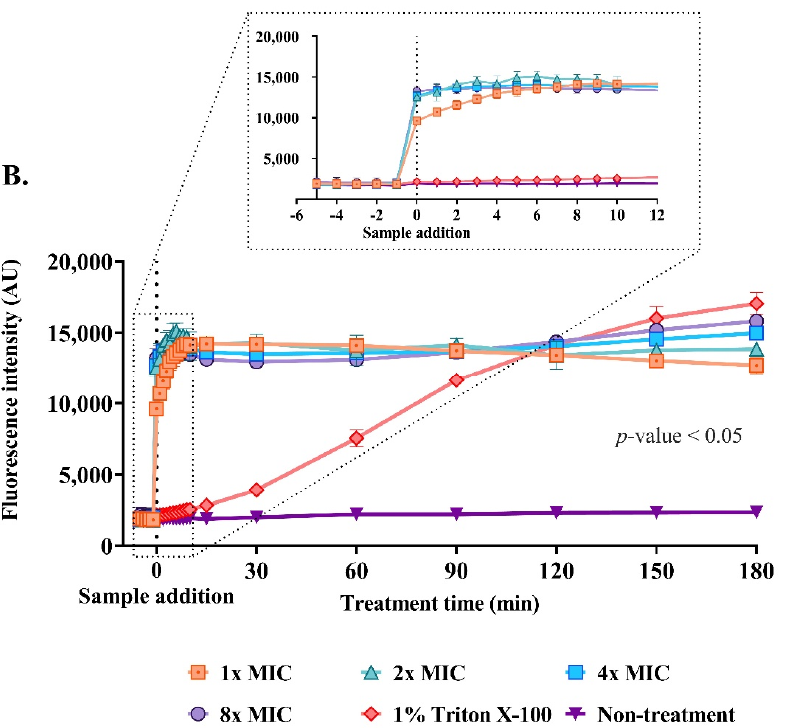
Figure 9. Effect of anti-MRSA peptide (P1) on membrane permeability. The cell cultures of ( A ) S. aureus TISTR 517 and ( B ) MRSA isolate 2468 were incubated with different concentrations of P1 (1×, 2×, 4×, and 8× MIC). Sytox green uptake was determined by measuring the fluorescence intensity at 532 nm in specific time intervals (0, 2.5, 5, 10, 15, 30, 60, 90, 120, 150, and 180 min). The inset graph was determined between treated and non-treated samples ( p -value < 0.05) .